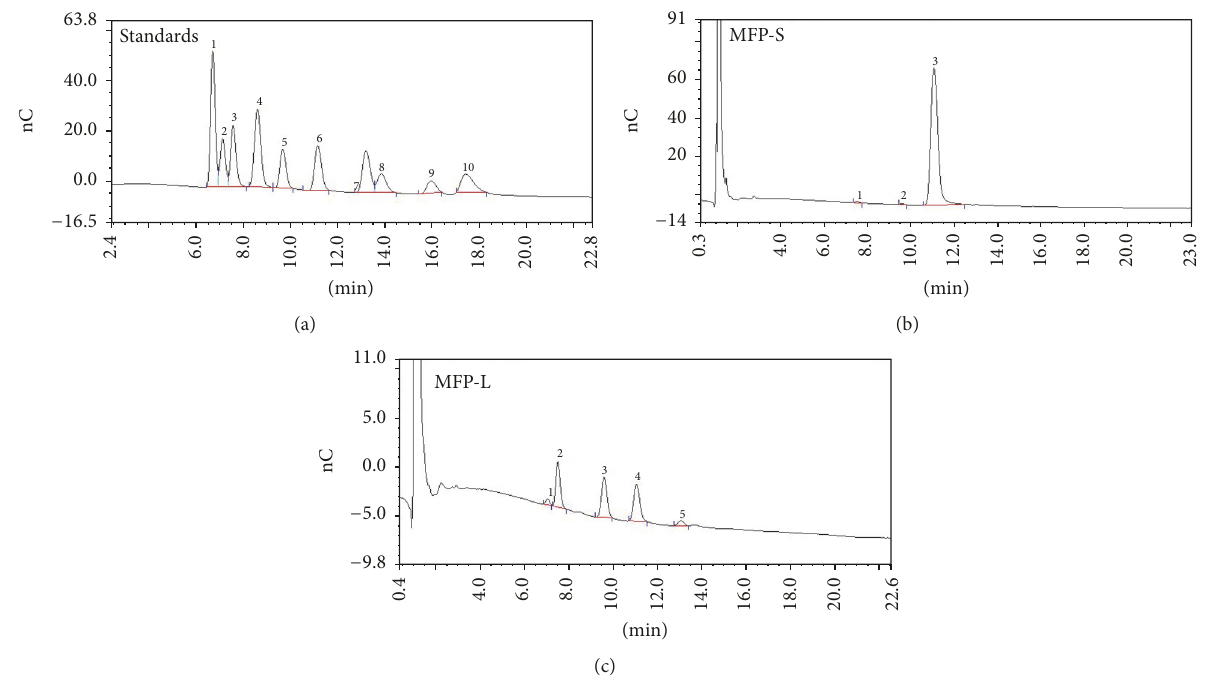
Figure 2: HPLC chromatograms of standard monosaccharides (a) and monosaccharide composition analysis of MFP-S (b) and MFP-L (c).